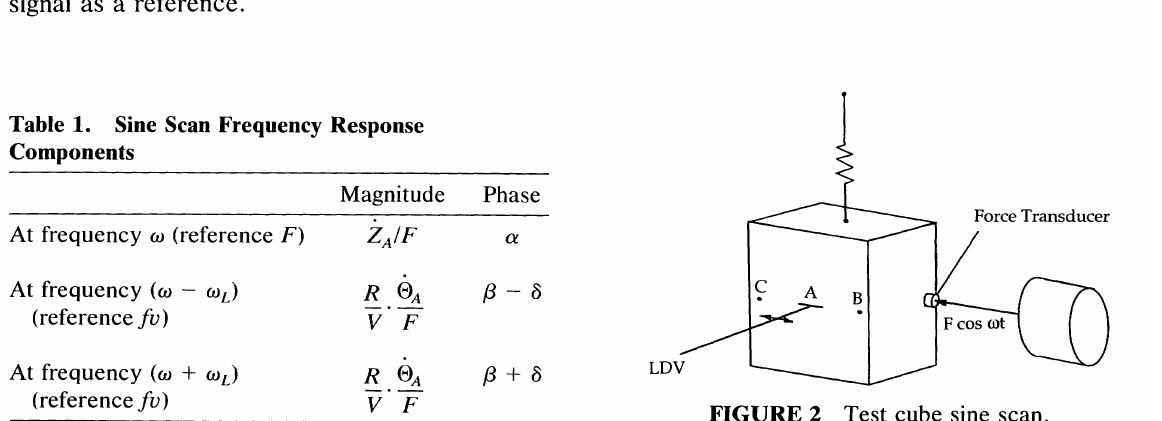
Table 1. Sine Scan Frequency Response